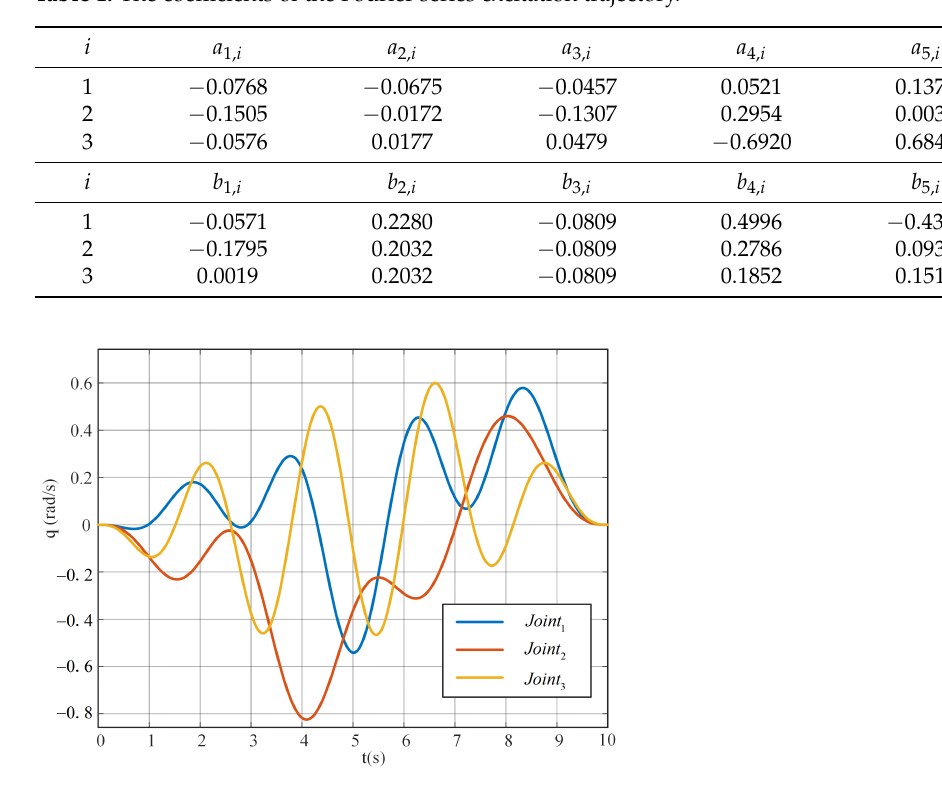
Table 1. The coefficients of the Fourier series excitation trajectory.